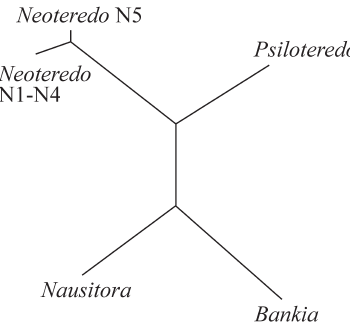
Figure 2 - Relationships between four Teredinidae genera. N1 to N5 rep- resent different Neoteredo reynei